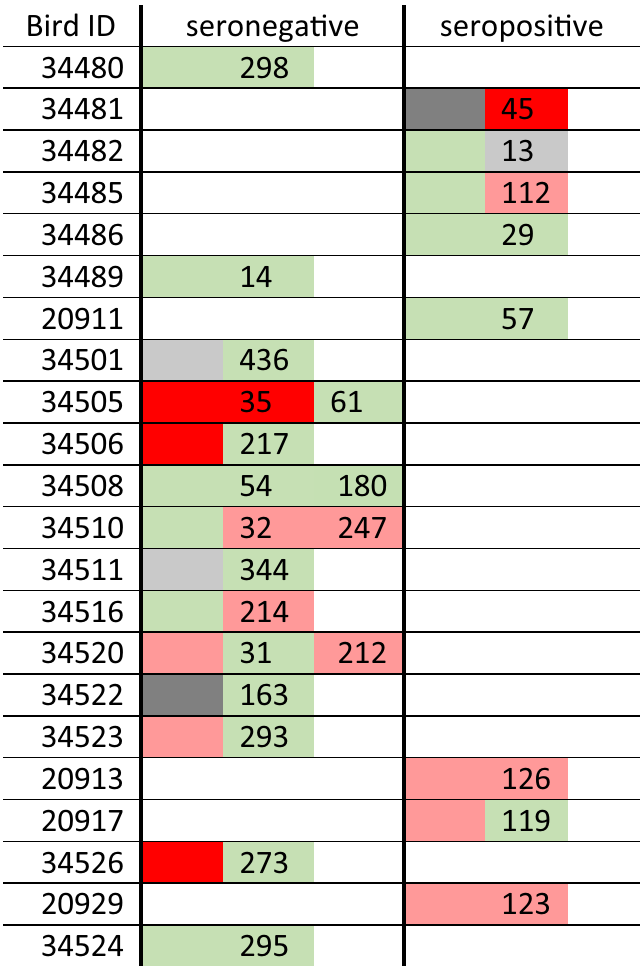
Table 3. Serology and Chlamydiales infection status per individual for each capture, in all individuals with seroprevalence data for multiple capture events (n = 22). The number indicates the number of days since the previous capture. Colour indicates chlamydial PCR test status: green is negative, pale red is Chlamydiales positive, bright red is C. psittaci positive, and dark grey is inconclusive. Light grey indicates captures where no cloacal swab was